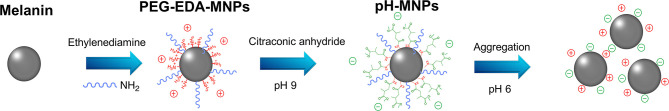
A schematic illustration of the preparation process of the pH-MNPs.